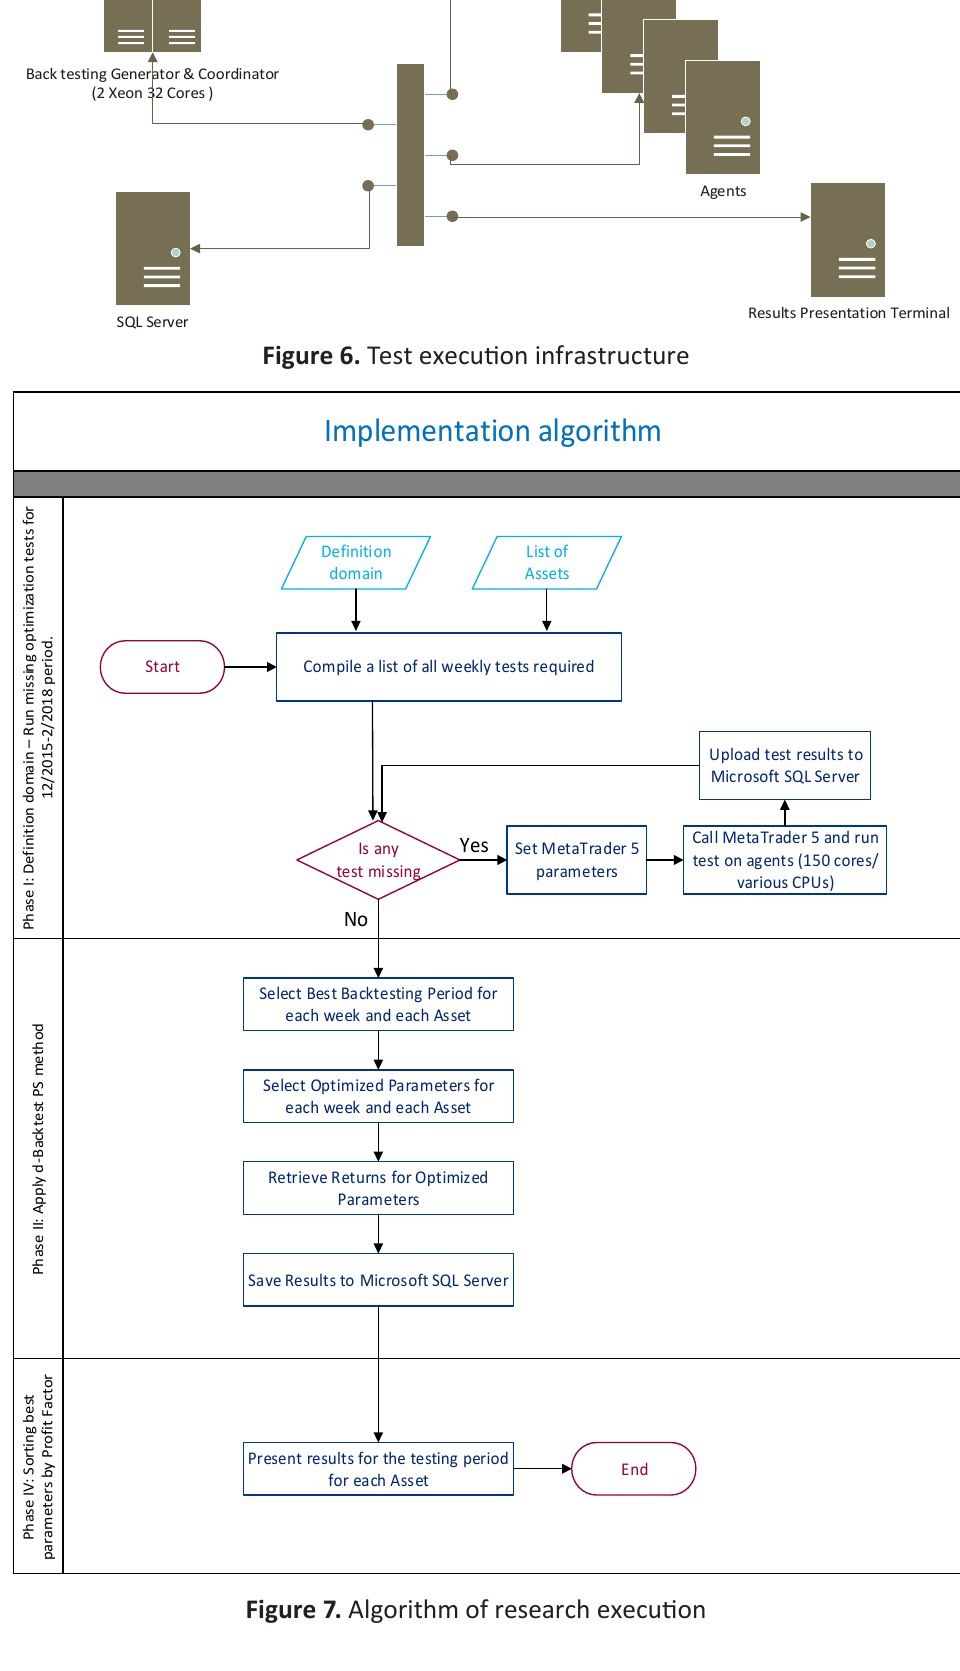
Figure 7. Algorithm of research